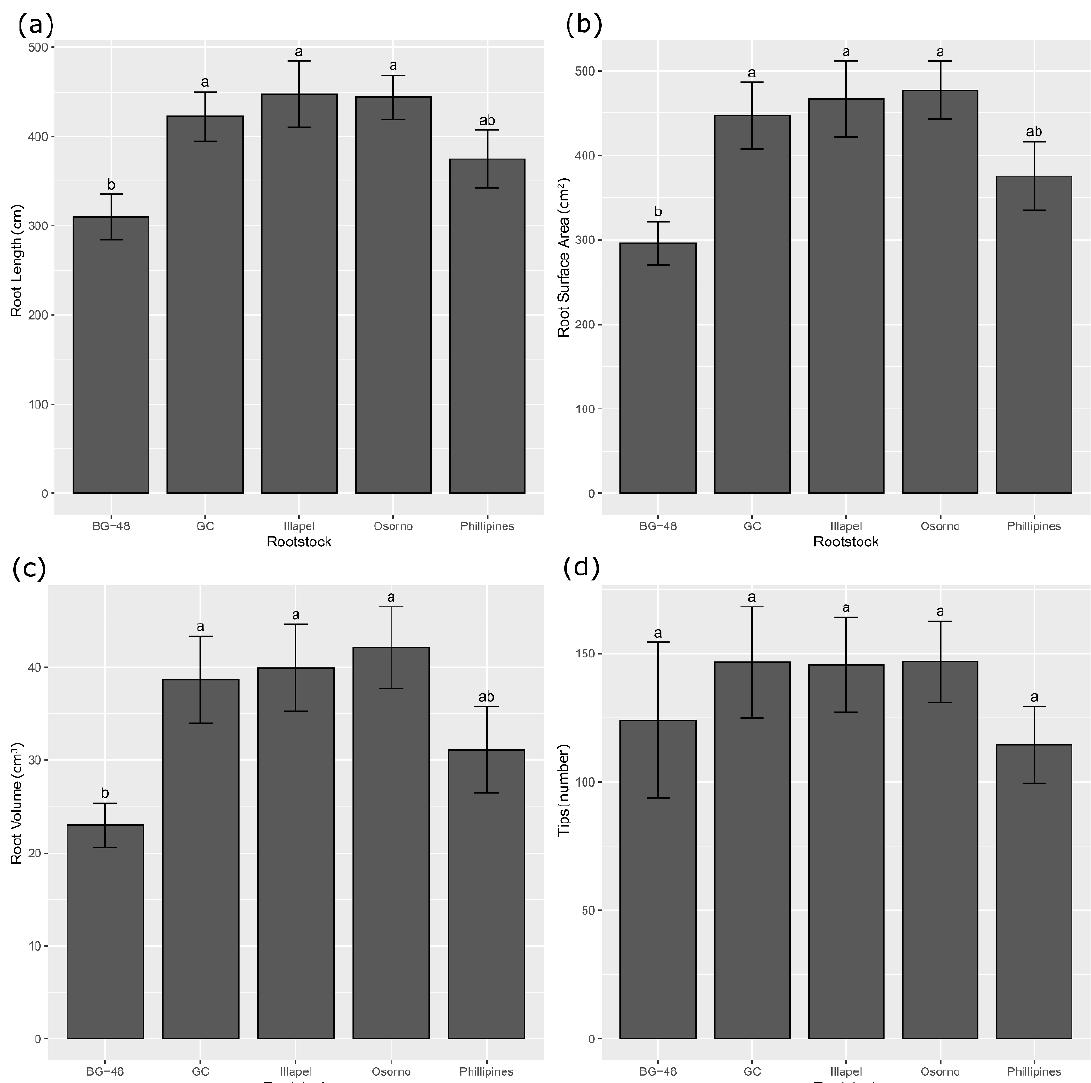
Figure 3. Root system architecture traits of L. siceraria rootstocks grafted onto watermelon cv. Santa Amelia F1 and grown under field conditions. ( a ) Root length, ( b ) surface area, ( c ) root volume, and ( d ) number of tips. Different letters indicate significant differences according to Fisher’s LSD test ( p ≤ 0.01) with Bonferroni correction.